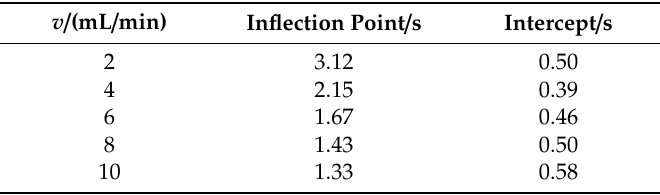
Table 1. The inflection point and intercept of the S-logistic line between the de-emulsification efficiency and the resident time.